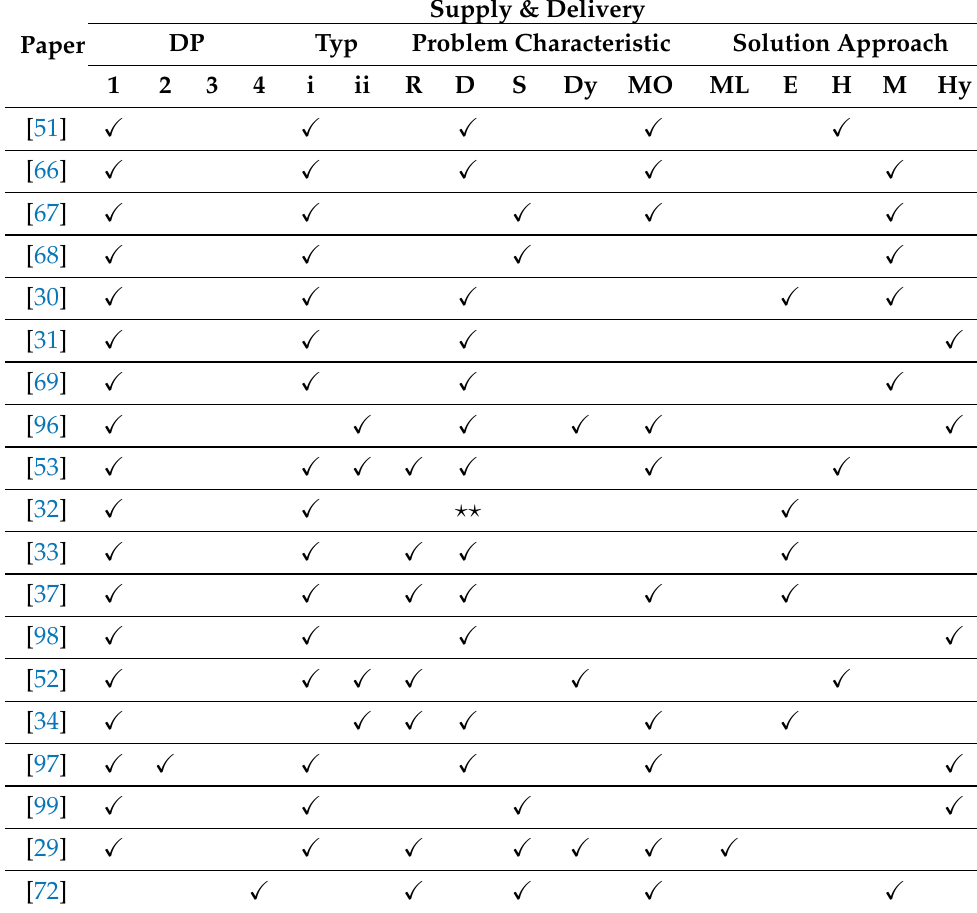
Table A4. VRPs for Supply and Delivery in Humanitarian Logistics.